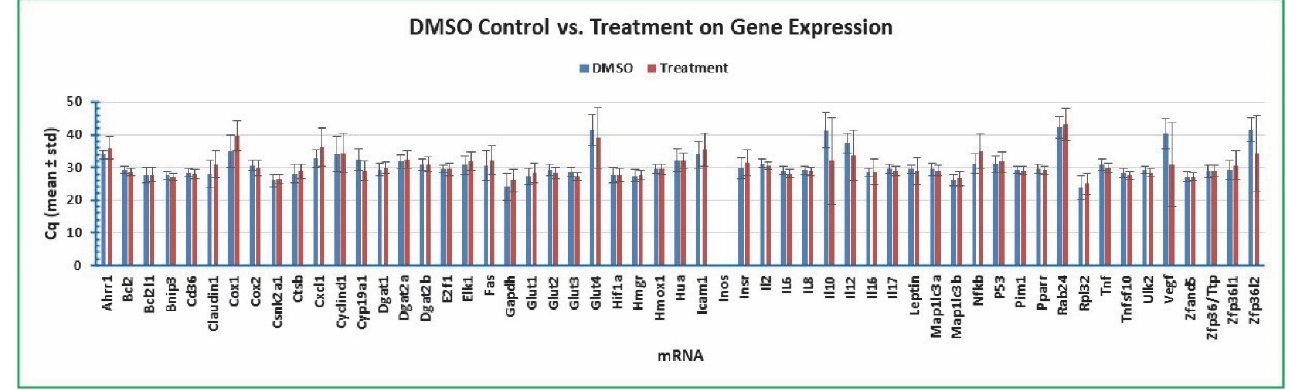
Figure 8. Variation of gene expression between DMSO control and treatment. The cancer cells were treated with 1% DMSO and multiple concentrations of gossypol (0.1, 0.5, 1, 5, 10, 50, and 100 µg/mL), LPS (5, 10, 20, 50, 100, 500, and 1000 ng/mL) and cottonseed extracts (5, 10, 20, 30, 40, 50, and 100 µg/mL) for 8 h and 24 h. Total mRNAs were extracted from the cells, converted into cDNAs, and the relative abundance was analyzed by SYBR Green qPCR. The Cq values represented the mean and standard deviation of 24 independent samples.